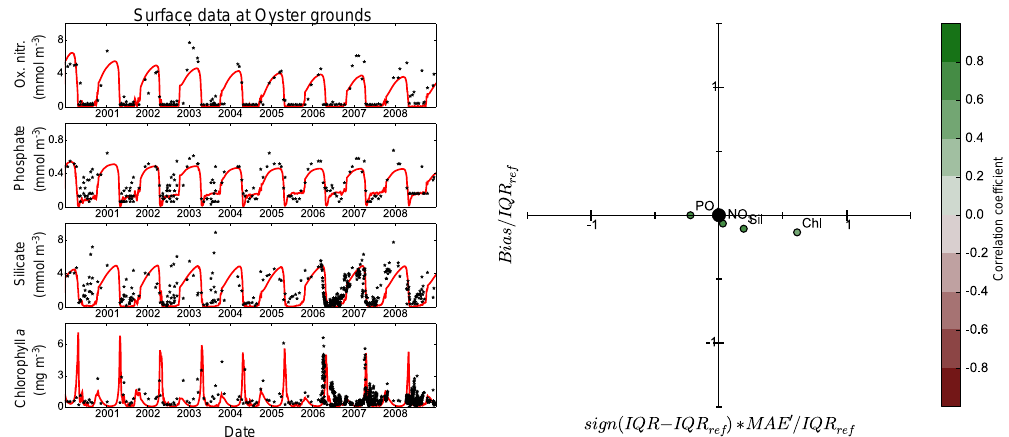
Figure 7. Simulation results vs. in situ data at the Oyster Grounds – left panels: model time series (red lines) vs. in situ measurements (black dots) for oxidized nitrogen, phosphate, silicate, and chlorophyll a (top to bottom panels); right panel: target diagram with bias (ab- scissa), MAE’ (ordinate), and Spearman correlation (colour code) for oxidized nitrogen (NO 3 ), phosphate (PO 4 ), silicate (Sil), and chloro- phyll a (Chl). The observations consist of ship-based data collected by Rijkswaterstaat as part of Dutch national monitoring programme MWTL (see publicwiki.deltares.nl/display/OET/Dataset+documentation+MWTL) and SmartBuoy data collected by Cefas in collaboration with Rijkswaterstaat (Greenwood et al., 2010; http://www.cefas.co.uk/publications-data/smartbuoys).